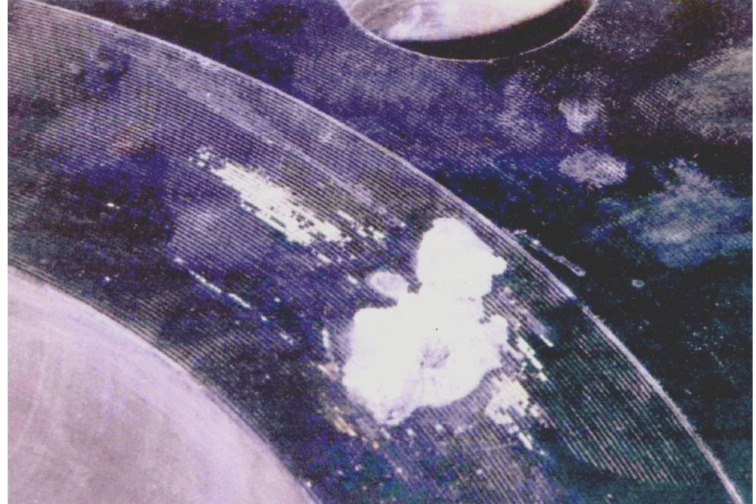
Figure 4. Corrosion of a superduplex flange under a graphite-containing gasket